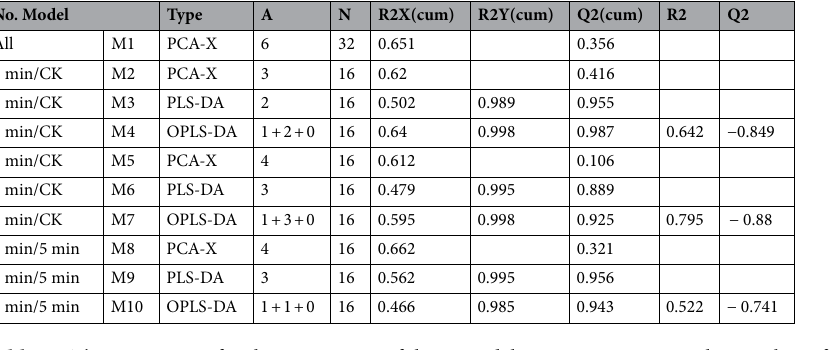
Table 1. The parameters for the assessment of these models. Note A represents the number of principal components (PC) while each model is constructed, N represents the numbers of samples analyzed, M1-M10 represents Model 1–10, R2X (cum) represents the interpretation rate of each model in the X axis direction in multivariate statistical analysis modeling, R2Y (cum) represents the interpretation rate of each model in Y axis direction in multivariate statistical analysis modeling, Q2 (cum) represents the prediction rate of each model, R2 represents the intercept value of the Y axis and the regression line, which is obtained when Linear regression analysis between the Y matrix of the original classification, the Y matrices of N times’ different permutations and R2Y was conducted during model validation, and Q2 for the intercept value of the Y axis and the regression line, which is obtained when Linear regression analysis between the Y matrix of the original classification, the Y matrices of N times’ different permutations and Q2Y was conducted during model validation. For Q2 in external validation, general requirement is that Q2 < 0, overfitting is avoided. For R2X, general requirement is that R2X > 0.4, the model is good. For R2 in internal validation, general requirement is that R2 > 0.5, the closer to 1, the better the model.